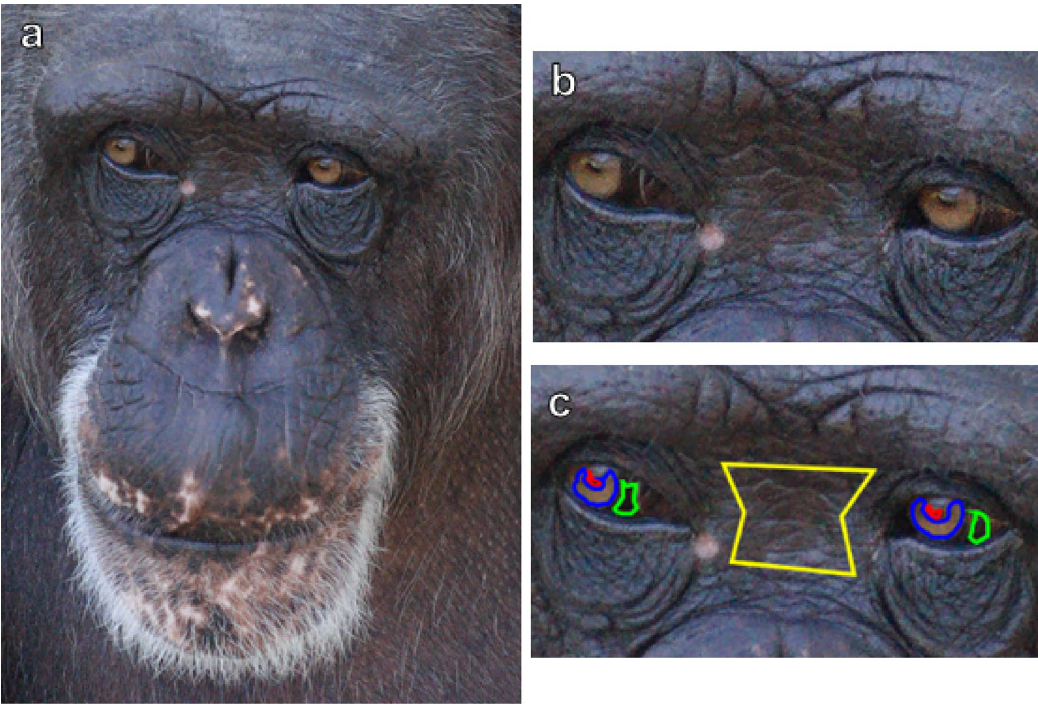
Figure 1. Chimpanzee face. ( a ) A sample photograph of a chimpanzee. ( b ) Enlarged view of the regions of the chimpanzee’s eye region. ( c ) Example ROIs for this photograph with pupil outlined in red, iris in blue, sclera in green, and skin in yellow. We omitted highlights in the ocular media, like the visible reflection of the sky, from all ROIs.